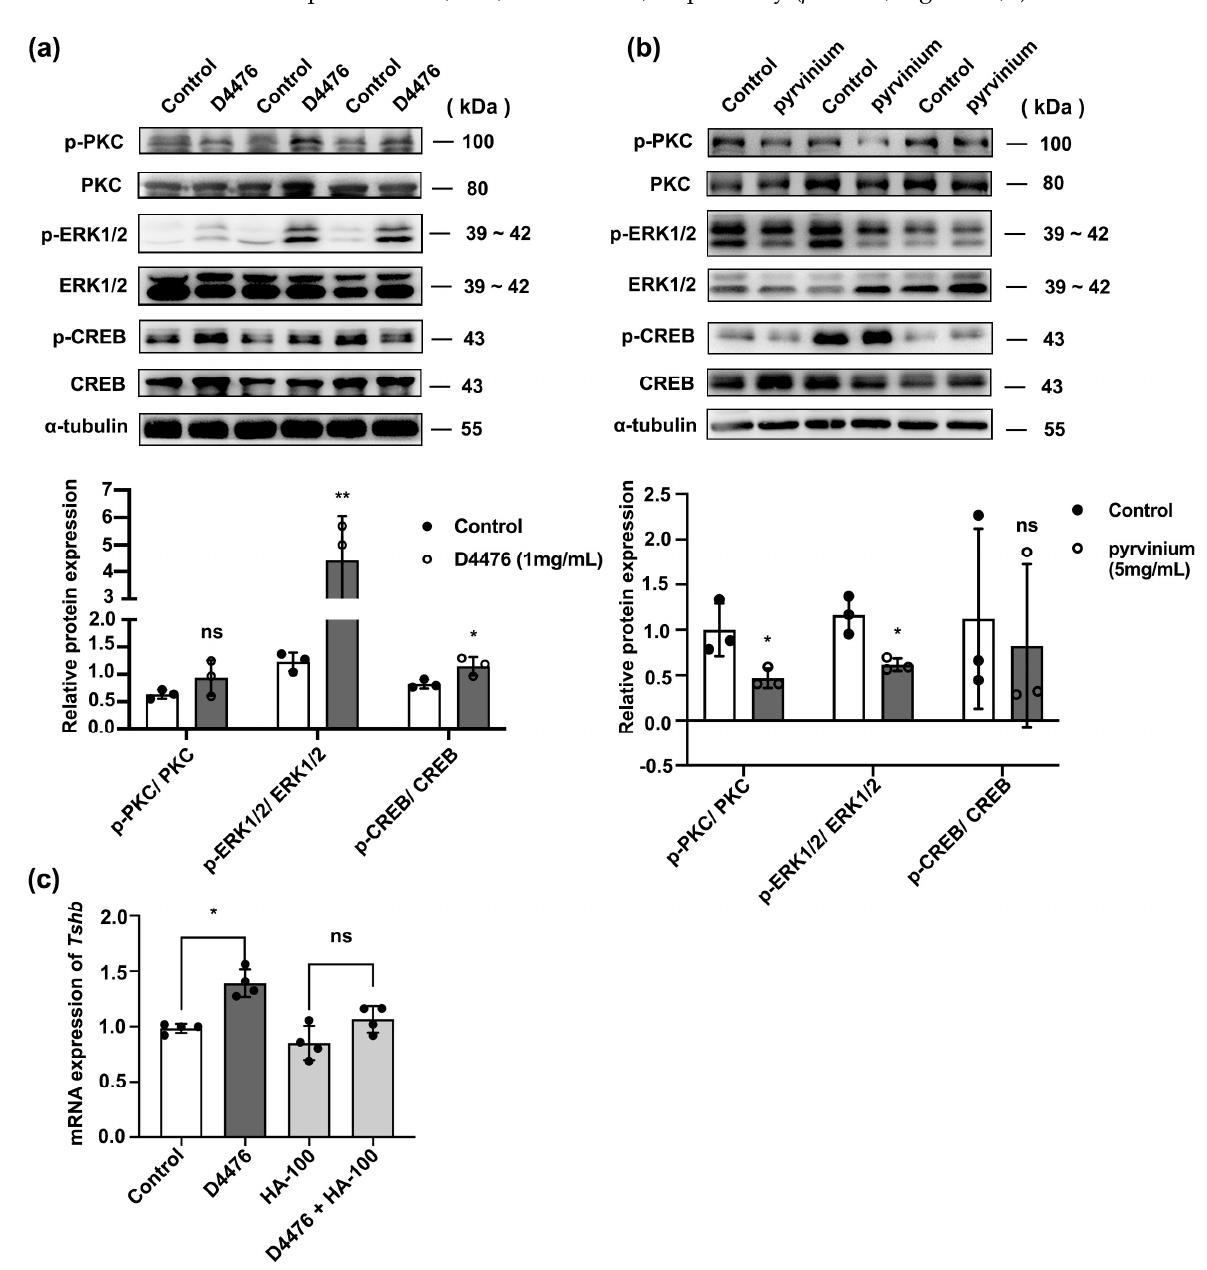
Figure 3. CK1 α regulates the PKC/ERK/CREB signaling pathway upstream of TSH synthesis. ( a , b ) After intravenous injection of the CK1 α inhibitor D4476 or activator pyrvinium, p-PKC, p-ERK1/2, p-CREB, PKC, ERK1/2, and CREB expression levels were analyzed using Western blotting. Relative p-PKC, p-ERK1/2, and p-CREB protein levels were normalized to those of total PKC, ERK1/2, and CREB; * p < 0.05, ** p < 0.01 and ns = no significant, n = 3. ( c ) The expression of Tshb was measured using RT-PCR in primary pituitary cells pre-treated with HA-100 and treated with D4476 for 6 h. Gapdh was used as the internal reference. * p < 0.05 and ns = no significant, n = 3. These results were confirmed in cultured primary pituitary cells, which were pre- treated with 12 µ M PKC inhibitor HA-100 for 1 h, followed by treatment with 10 µ M